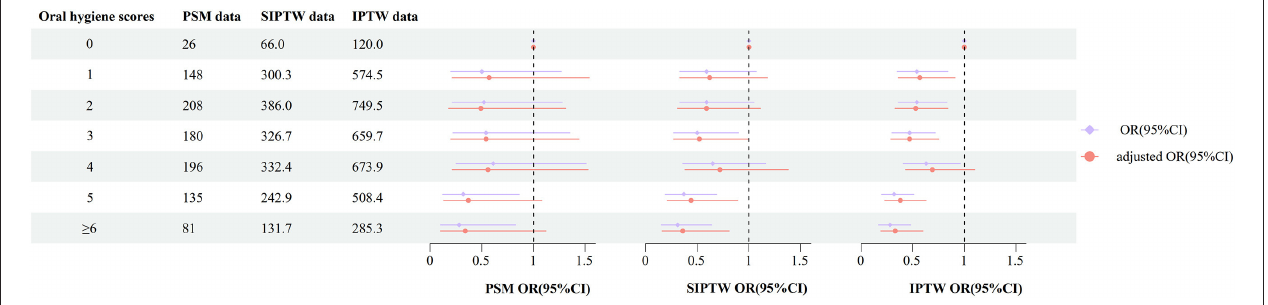
FIGURE 2 | Associations of oolong tea consumption and the risk of OSCC, stratified by different oral hygiene scores. Adjusted OR (95% CI) was calculated by adjusting for age, gender, occupation, education level, BMI, residence, smoking, and alcohol consumption, consumption frequency of red meat, vegetables, and